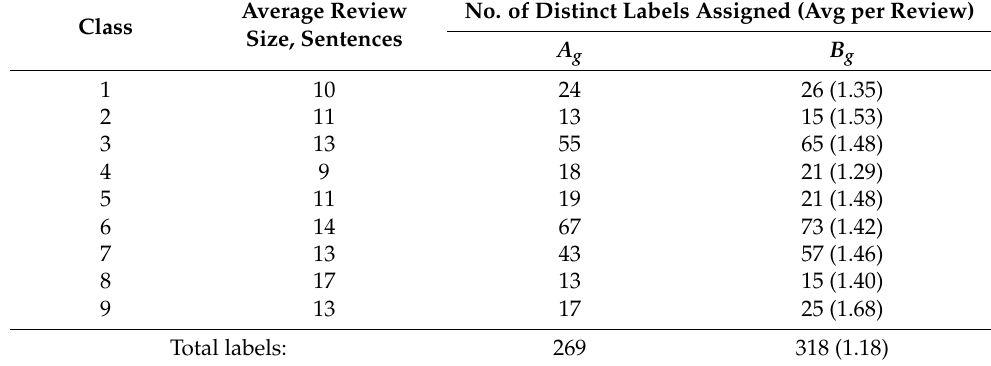
Table 7. Structure of the gold-standard labeled